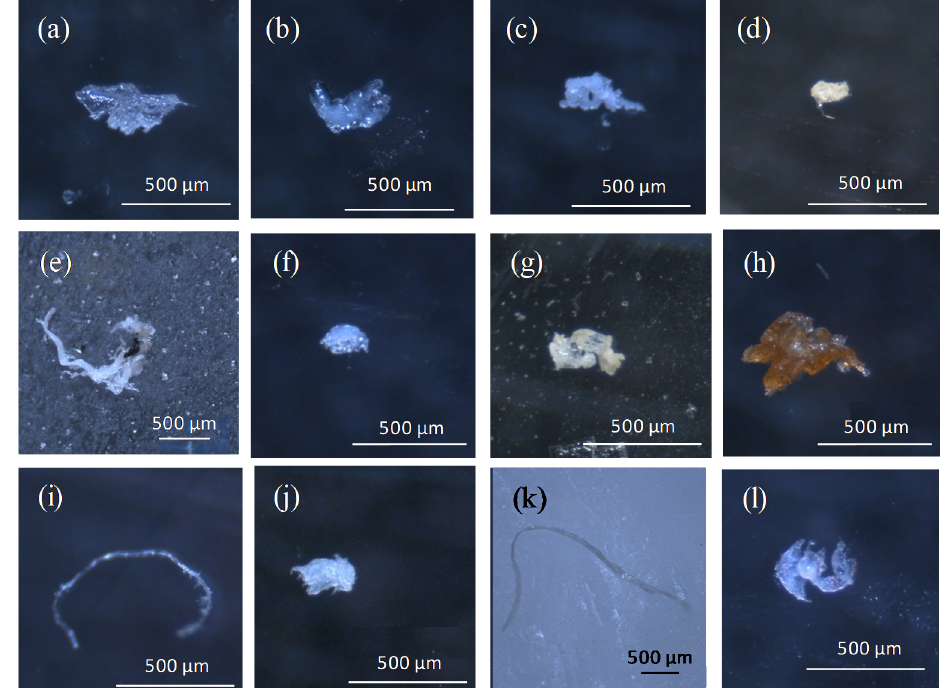
Figure 2. Microlitter ( a – d ) and microplastics ( e –l) in stomach (S) and intestine (I) of commercial gilthead seabream collected in the Mar Menor: ( a ) carboxymethylcellulose, sodium salt (I); ( b ) glycerol monooleate (S); ( c ) sodium stearate (S); ( d ) paraffin wax (I); ( e ) poly(ethylene) (low density) (S); ( f ) eva foam concentrate,10% azodicarbonamide (S); ( g ) polyethylene, linear (I); ( h ) poly(ethylene) (high density) (S); ( i ) unknown fiber (I); ( j ) polyethylene type F (S); ( k ) poly(ethylene) (low density) (S); ( l ) poly(ethylene:vinyl acetate) (9% vinyl acetate) (S).